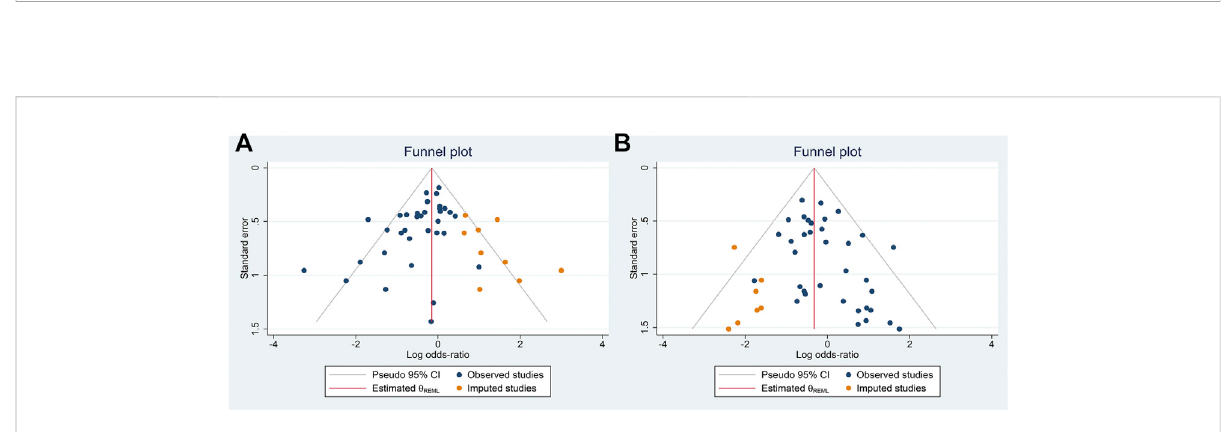
FIGURE 10 (A) Trim-and- fi ll analysis of EM vs. IM in relation to the H. pylori cure rate in the CYP2C19 genotype. Nine studies needed to be fi lled. (B) Trim- and- fi ll analysis of IM vs. PM in relation to the H. pylori cure rate in the CYP2C19 genotype. Seven studies needed to be fi